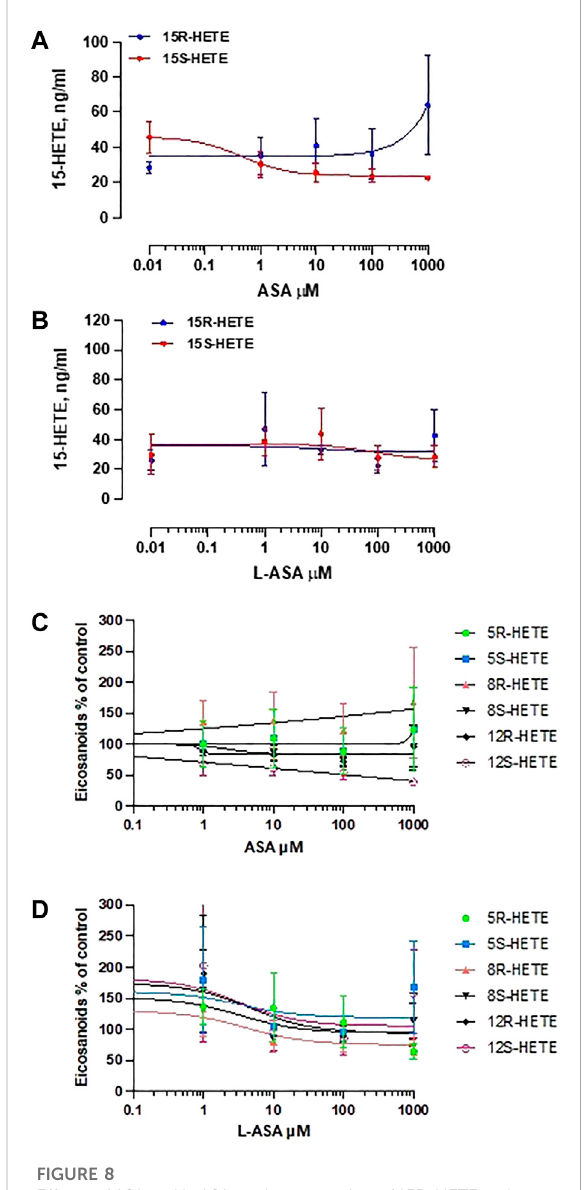
FIGURE 8 Effects of ASA and L-ASA on the generation of 15R-HETE and 15S-HETE and other HETEs in HCA7 cells in response to AA 100 μ M. HCA7 cells were treated with DMSO or diluent or increasing concentrations of the ASA (A) or L-ASA (B) for 30 min at 37 ° C; then, cells were incubated with AA100 µM for 30 min at 37 ° C, and the levels of 15S-HETE and 15R-HETE were assessed by LC-MS/MS; data are shown as ng/ml and reported as mean±SEM,n=4.TheeffectsofASAandL-ASAonotherHETEsis shown in panel (C) and (D), respectively and reported as % of control (mean ± SEM, n =